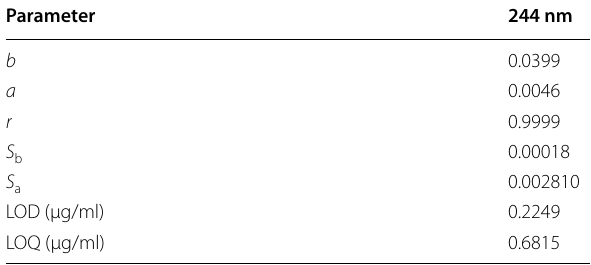
Table 4 Atorvastatin linearity data (absorbance factor method)